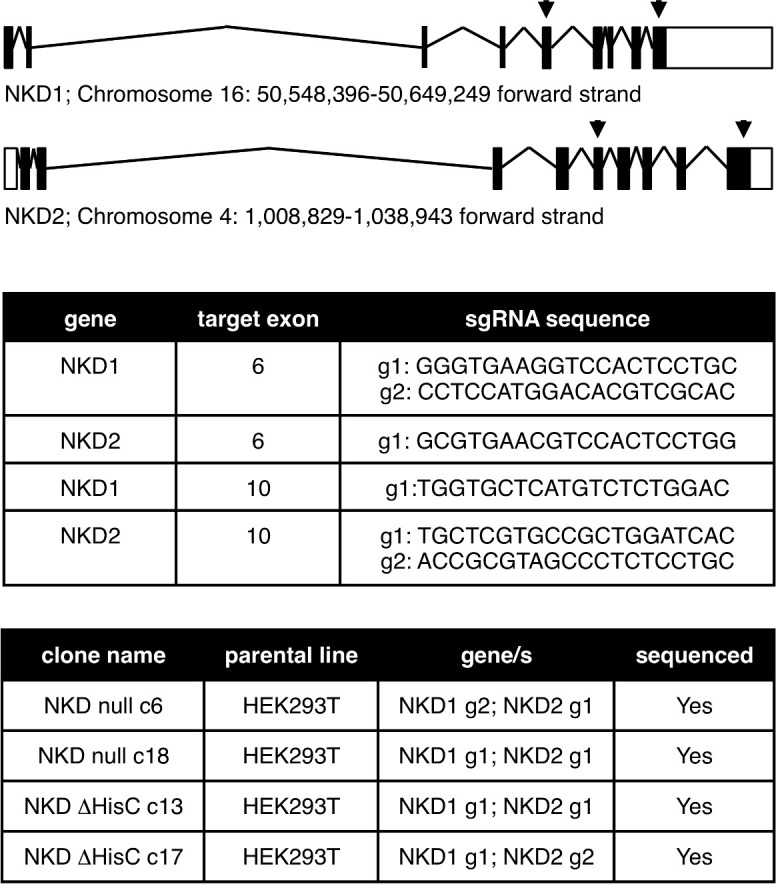
CRISPR engineering of HEK293T cells.Top, genomic locations and organizations of the human NKD1 and NKD2 loci, with positions of CRISPR gRNAs indicated; underneath, sequences of gRNAs used for generating truncations in two different NKD null (c6 and c18) or ΔHisC (c13 and c17) lines, each verified by sequencing of both genes.